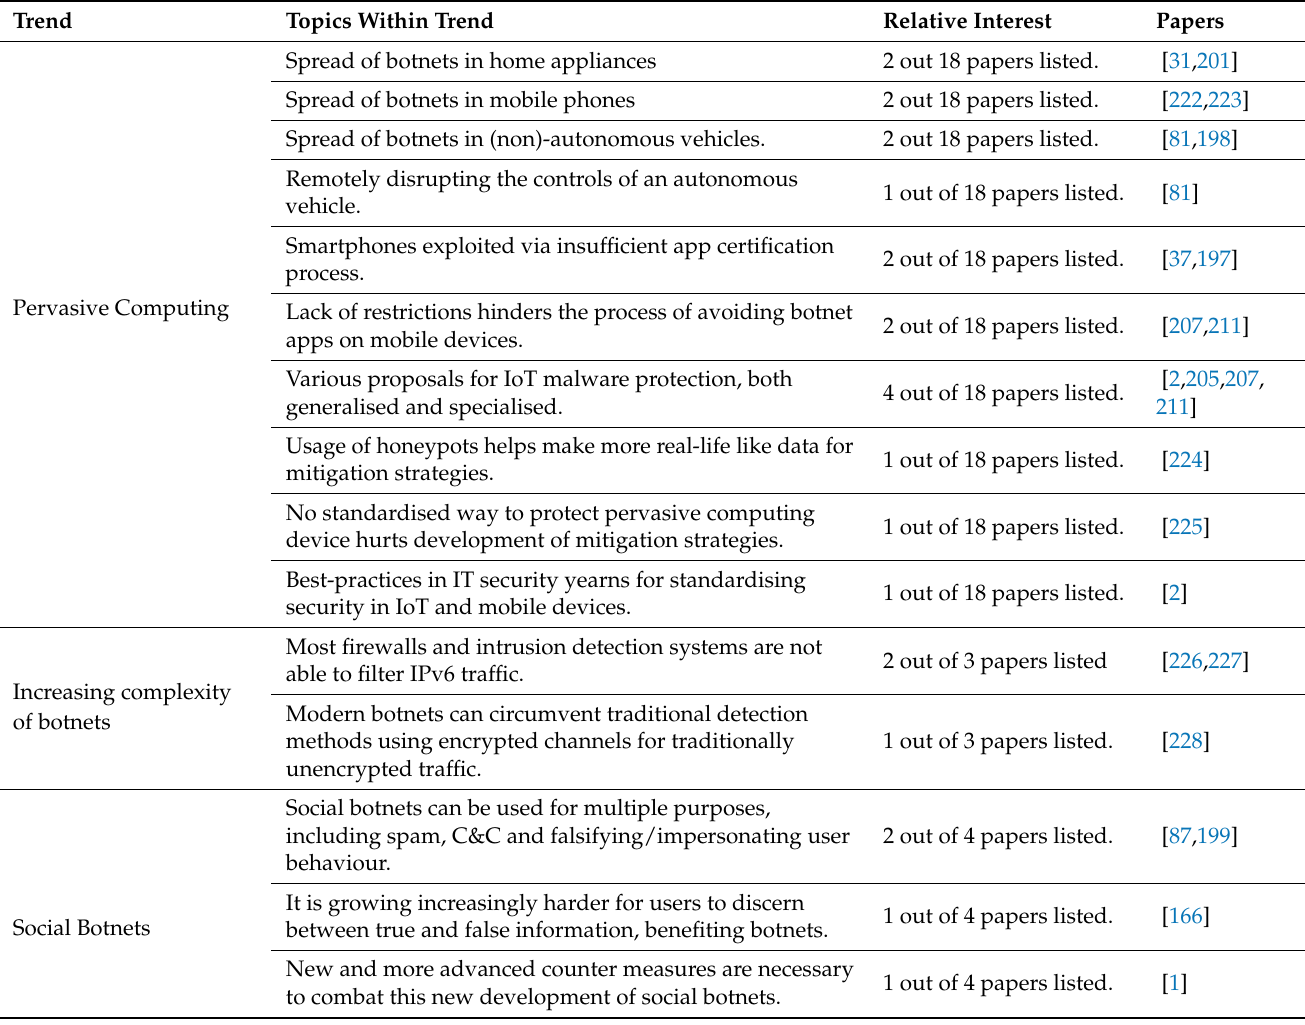
Table 10. Overview of papers discussing current trends and topics concerning botnets. The columns describes the trends of the overall associated area of interest, the detailed topics discussed in each paper, the relative interest amongst the associated trend and finally a listing of all the associated